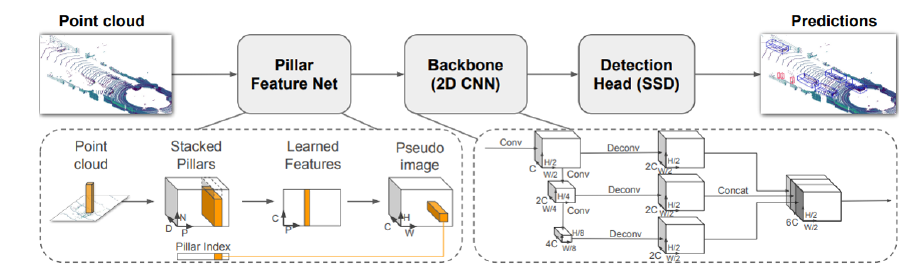
Figure 7. Scheme flow of PointPillars